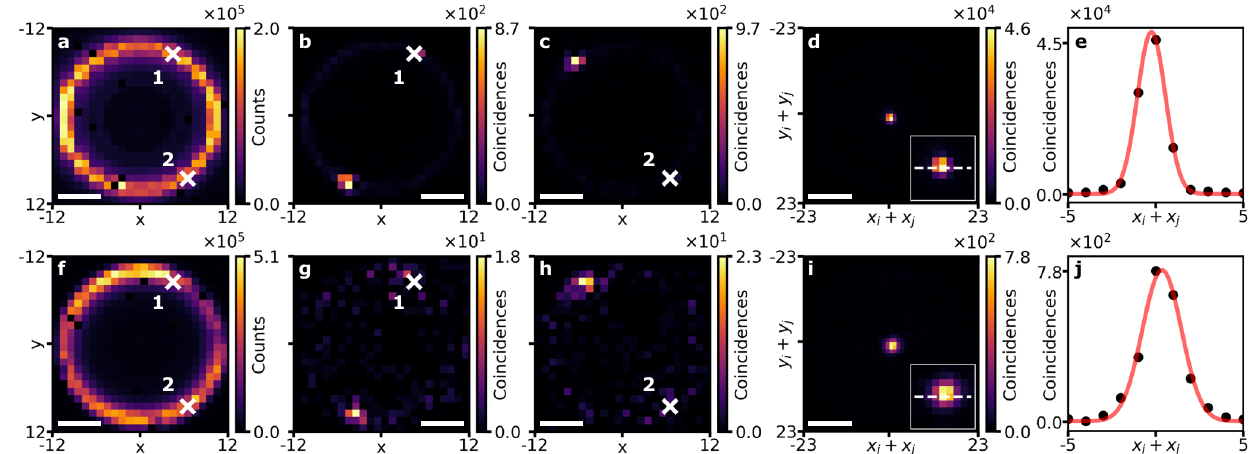
Fig. 3 Wide- fi eld propagation of quantum light through phase-separated fi ber, imaged with a single-photon avalanche diode array camera. a Input intensity image. The color bar depicts the number of total single-photon counts per pixel, which accumulate over acquisition time. Scale bar, 400 μ m. b , c Input coincidences with single fi xed pixel indicated by “ X ” , with pixel locations on spontaneous parametric down-conversion ring also shown in a . Color bars quantify coincidences per pixel. Scale bar, 400 μ m. d All input coincidences projected into sum-coordinates r i + r j . Inset shows close-up of peak. Color bar quanti fi es coincidences projected into the sum-coordinates. Scale bar, 800 μ m. e Cross-section along dashed white line in d , showing experimental values (black dots) and Gaussian fi tting (solid red). f – j are analogous to a – e , respectively, and show coincidences after propagating through